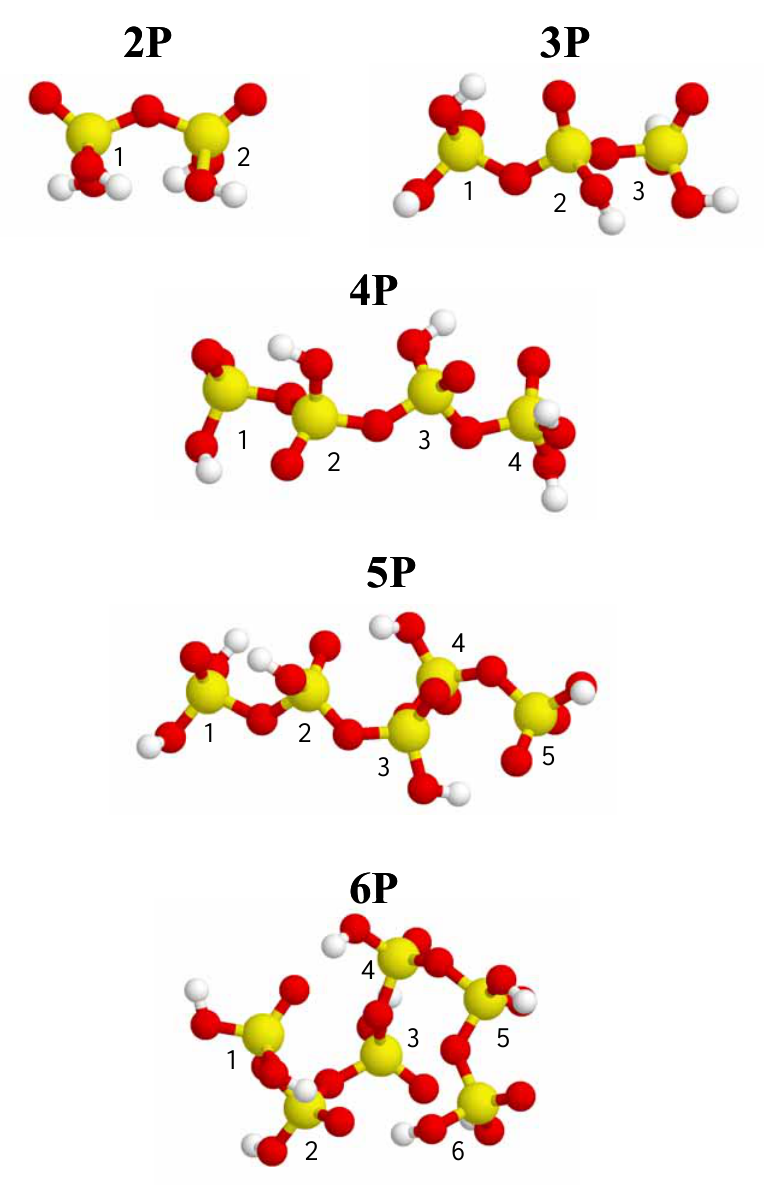
Figure 1. Different optimized conformations for 2-P, 3-P, 4-P, 5-P and 6-P-membered acyclic phosphate clusters. Phosphorus is depicted as yellow, oxygen is red, and hydrogen is white. Each phosphorus nuclei has a number ID for identification with 31 P CSA tensor values listed in Table